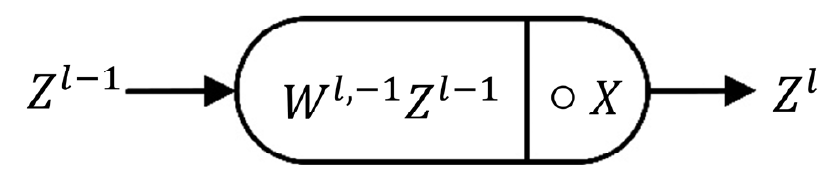
Figure 2. Dendrite module.